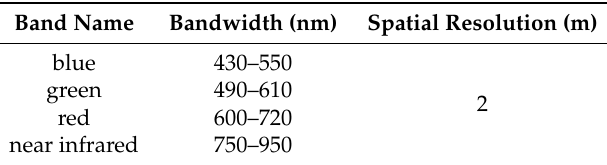
Table 1. Spectral and spatial characteristics of the multispectral image taken by the Plèiades-1